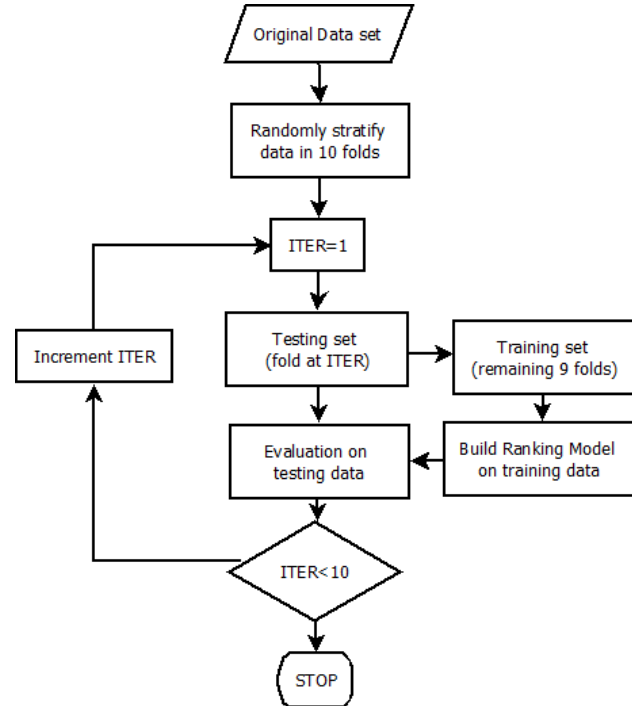
Figure 3. Flowchart for the experimental